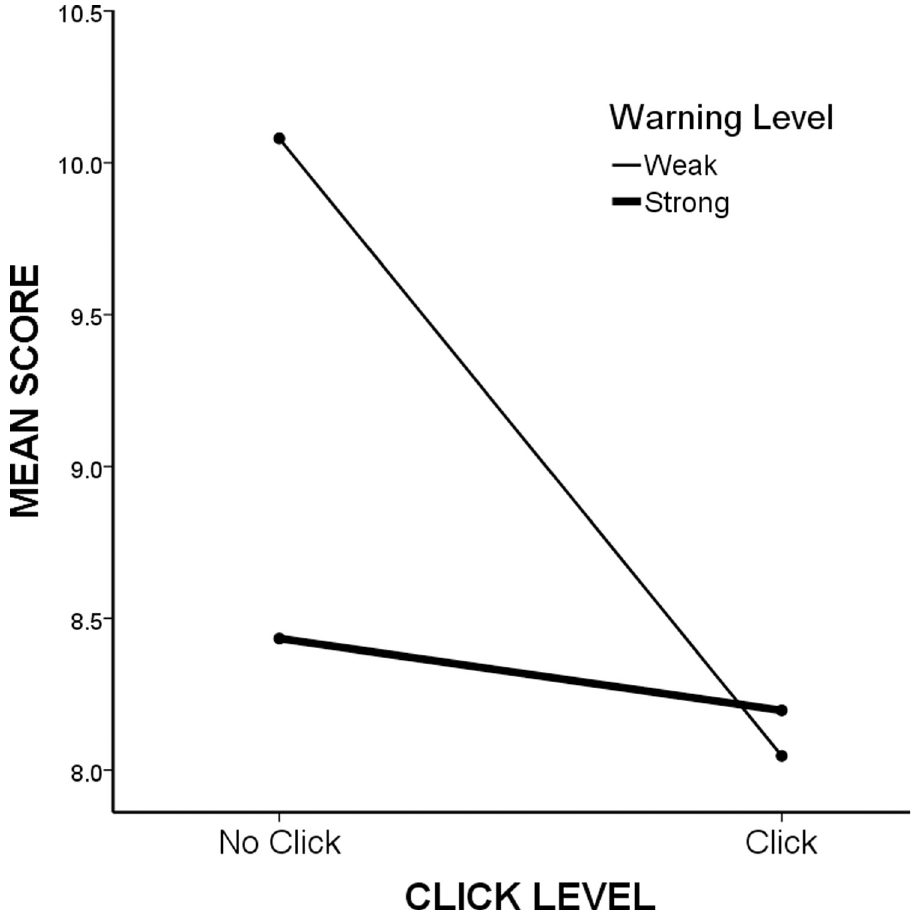
Fig 2. Graphical results of two-way ANOVA. It shows click level (no click or click) versus mean scores (mean number of “yes” responses). The thin line shows data for the weak warning condition, and the thick line shows data for the strong warning